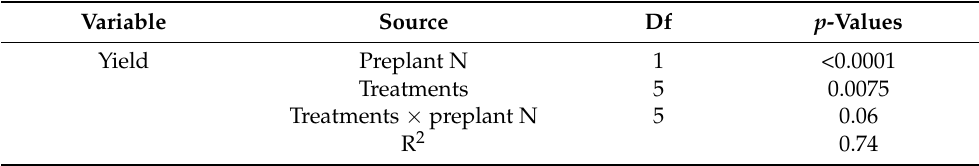
Table 5. Analysis of variance of yield as affected by the fixed effects of treatments and preplant N.